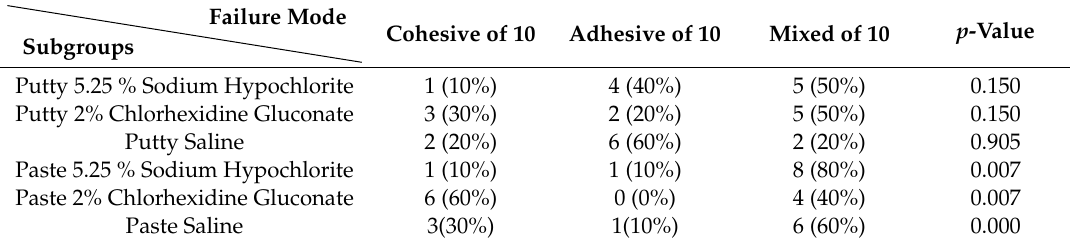
Table 1. Distribution of failure modes among the experimental subgroups: adhesive failure occurs at the dentin–material interface, cohesive failure occurs within the material, and mixed failure is a combination of the two failure modes.